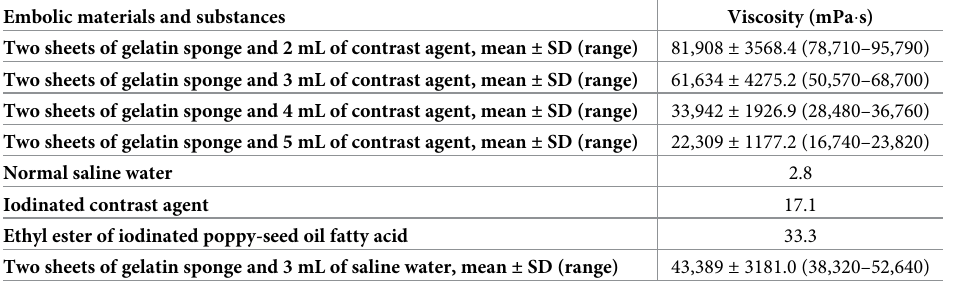
Table 2. Viscosity of all embolic materials and substances. Embolic materials and substances Viscosity (mPa � s) Two sheets of gelatin sponge and 2 mL of contrast agent, mean ± SD (range)